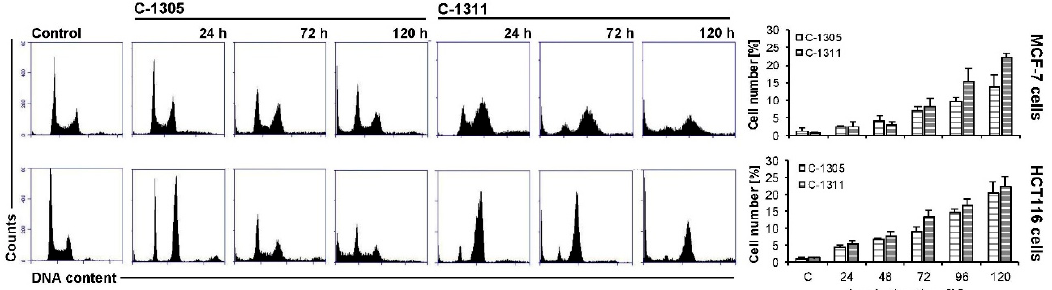
Figure 5. Cell cycle distribution of MCF-7-EV and HCT116-EV cells. Cells were untreated (control) or treated with IC 80 dosage for MCF-7 and IC 90 for HCT116 cells of C-1305 or C-1311 compounds for the times indicated and subjected to propidium iodide staining and flow cytometry as described in Materials and Methods. Histograms show number of cells ( y -axis) versus DNA content ( x -axis) and are representative of at least three experiments for each condition. Bar graphs show data quantitation with percentage of cells with less than 2N DNA (sub-G1 fraction).